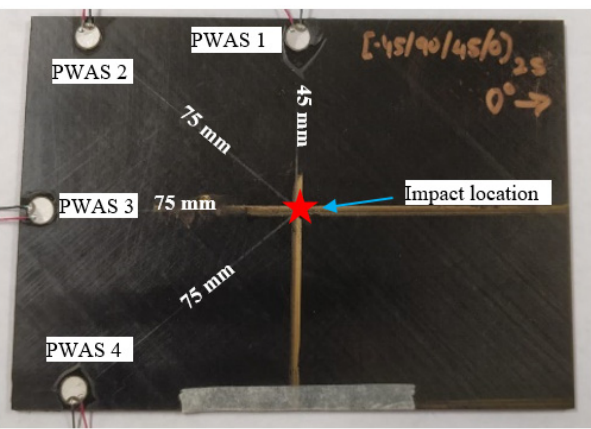
Figure 5. Location of four PWAS with respect to impact location on composite coupon.